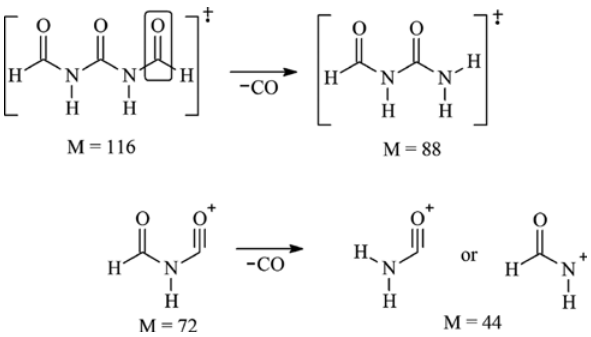
Figure 10: Possible fragmentation path for diformyl urea.